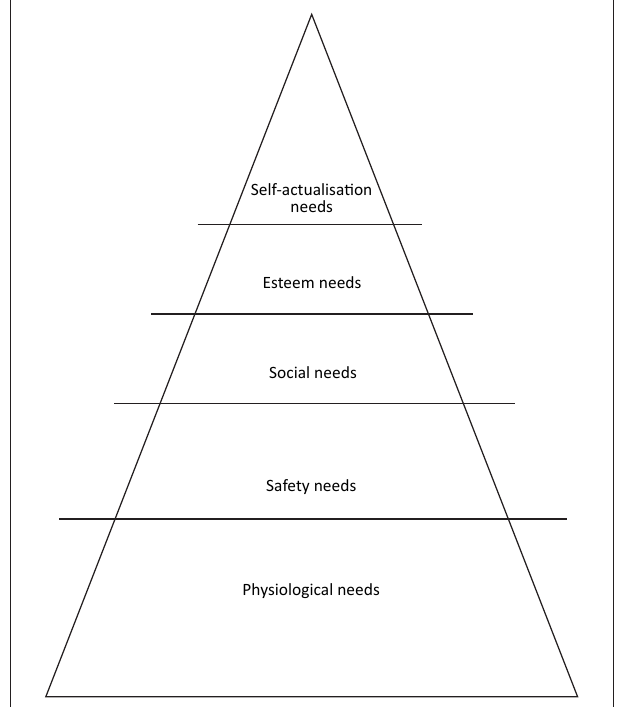
FIGURE 1: Maslow’s Hierarchy of